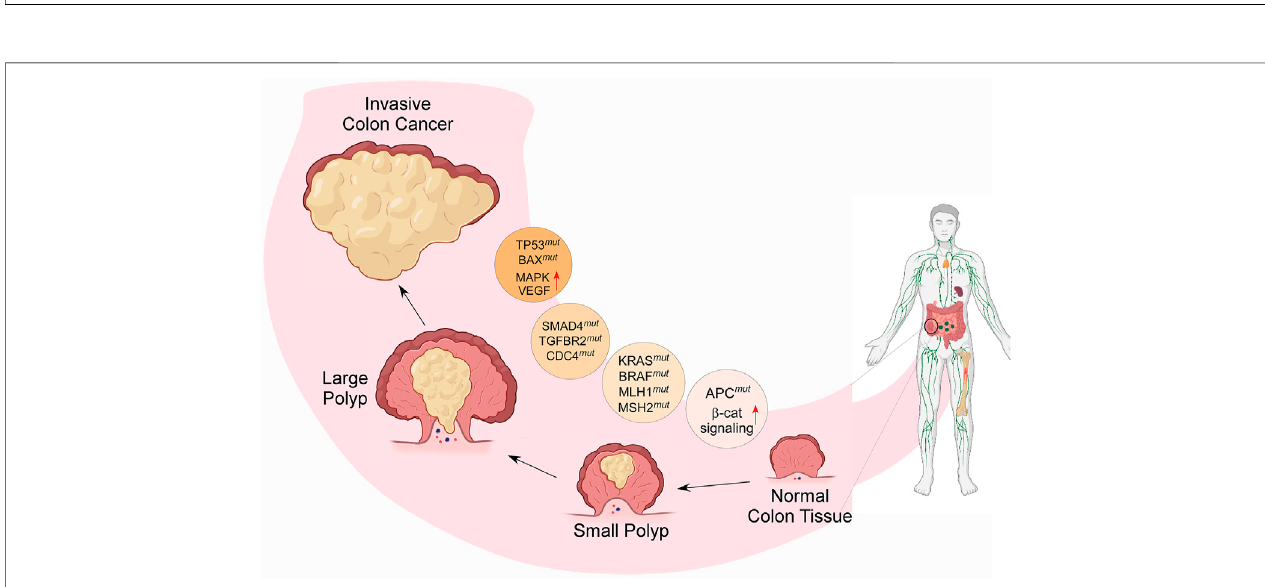
FIGURE1| TheorganicstructureofAndrographolide(C 20 H 30 O 5 ),containinga-alkylidenec-butyrolactonemoiety;twoole fi nbonds Δ 8(17)and Δ 12(13),andthree hydroxyls at C-3, C-14, and C-19 and its common analogues, Deoxyandrographolide, 14-deoxy- 11, 12-didehydroandrographolide, Neoandrographolide, Andrographoside, Stigmasterol.